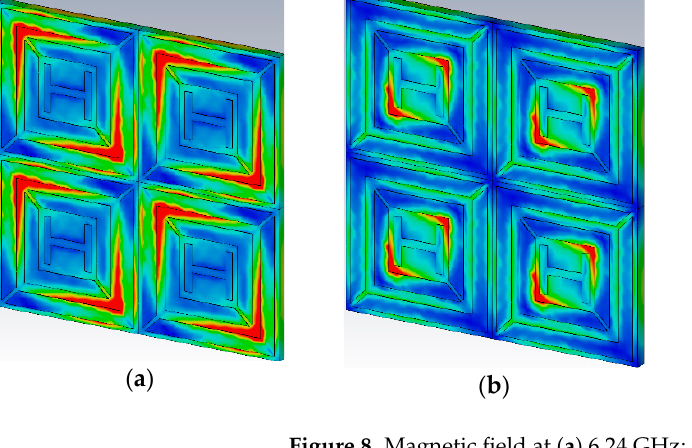
( b ) ( c ) ( d ) Figure 9. Surface current at ( a ) 6.24 GHz; ( b ) 10.608 GHz; ( c ) 18.624 GHz. ( d ) Scale and axis. 3.5. Metamaterial Characteristics The real and imaginary parts of the effective permittivity and permeability of the proposed unit cell are plotted in Figure 10. The proposed metamaterial demonstrates neg- ative permittivity and permeability values for real parts at frequencies of 6.24 GHz, 10.608 GHz, and 18.624 GHz. Thus, the proposed metamaterial exhibits double negative charac- teristics.